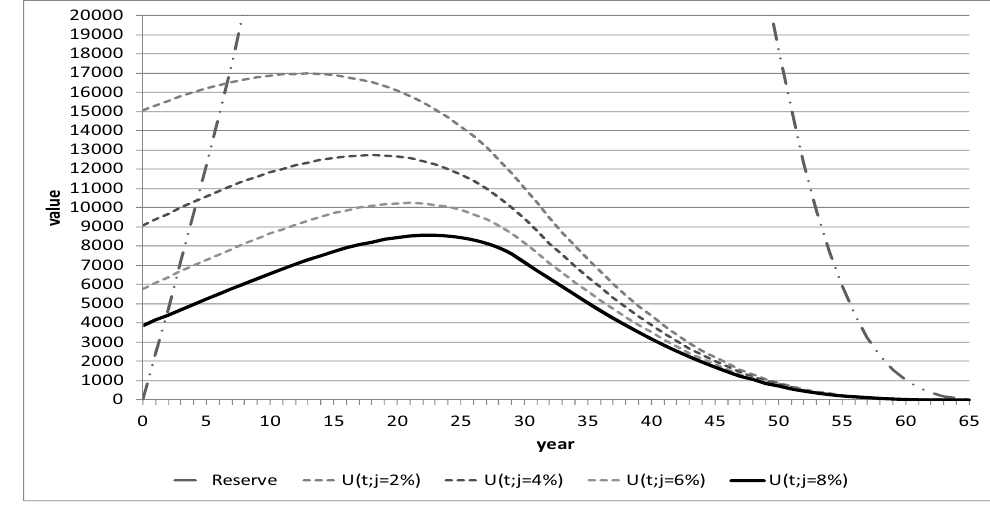
(cid:5) U for different evaluation rate j values t